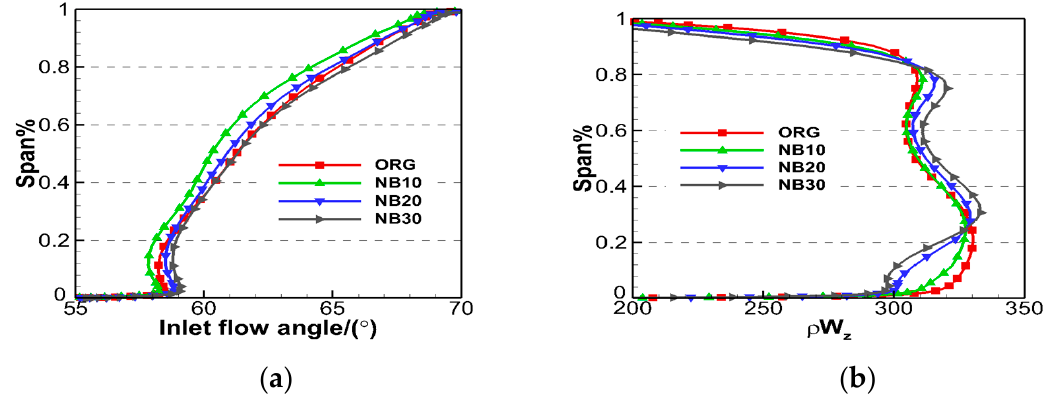
Figure 9. Comparison of spanwise distribution of the inlet flow angle and the axial velocity density (AVD) of NB10, NB20, and NB30. ( a ) the inlet flow angle. ( b ) the axial velocity density (AVD).